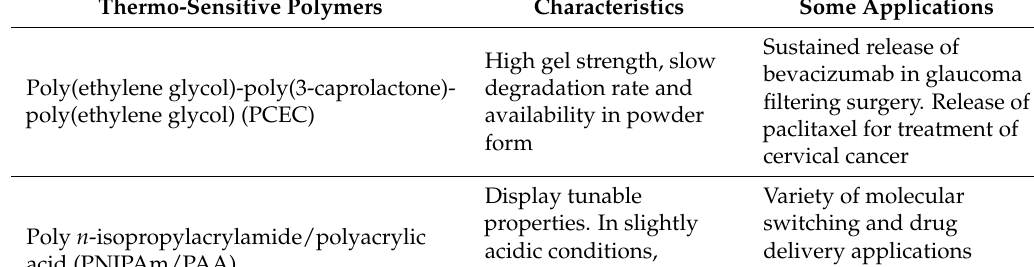
Table 1. Thermo-sensitive polymers used for the synthesis of hydrogels. Thermo-Sensitive Polymers Characteristics Some